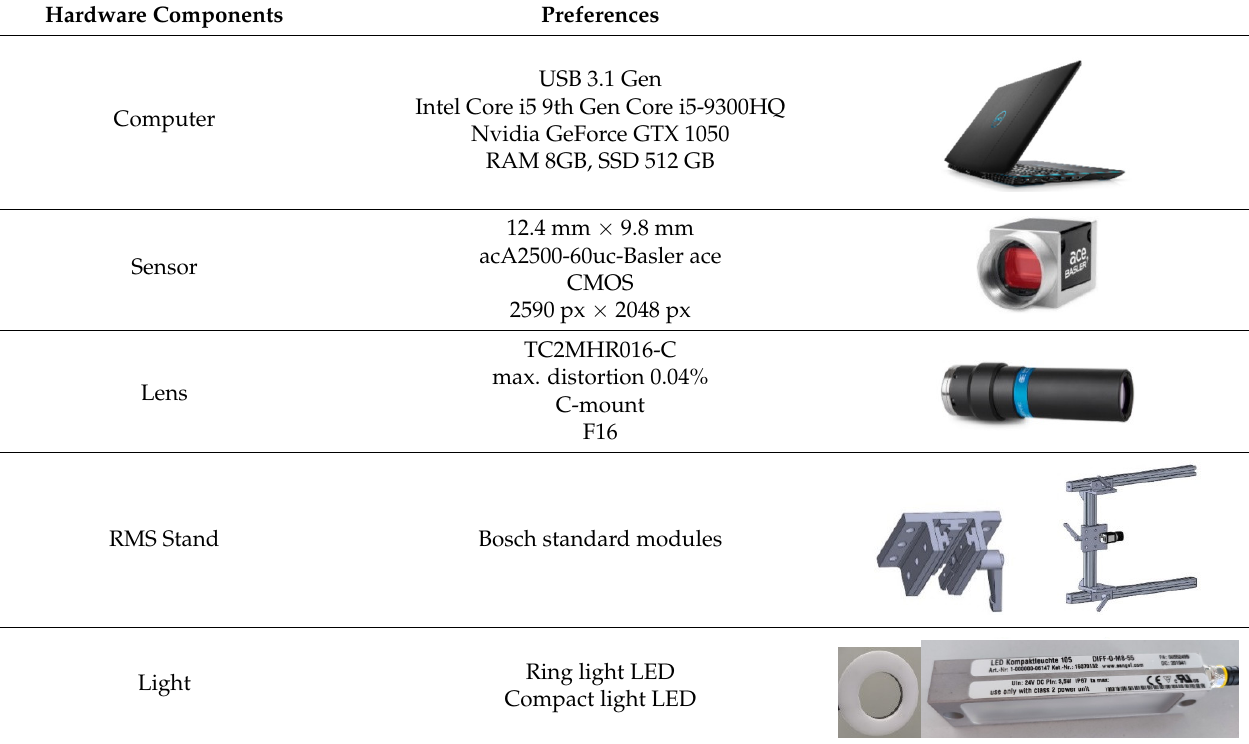
Table 1. Main components of reconfigurable measuring system with main specifications.